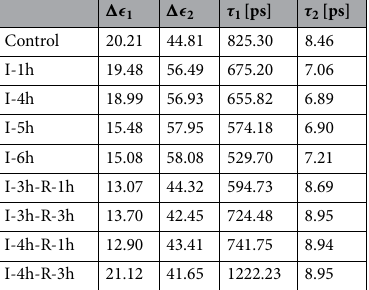
Table 1. Extracted Cole–Cole parameter from fitting equation (4) to the experimental data. “I” = Ischemia, “R” = Reperfusion and “h” =